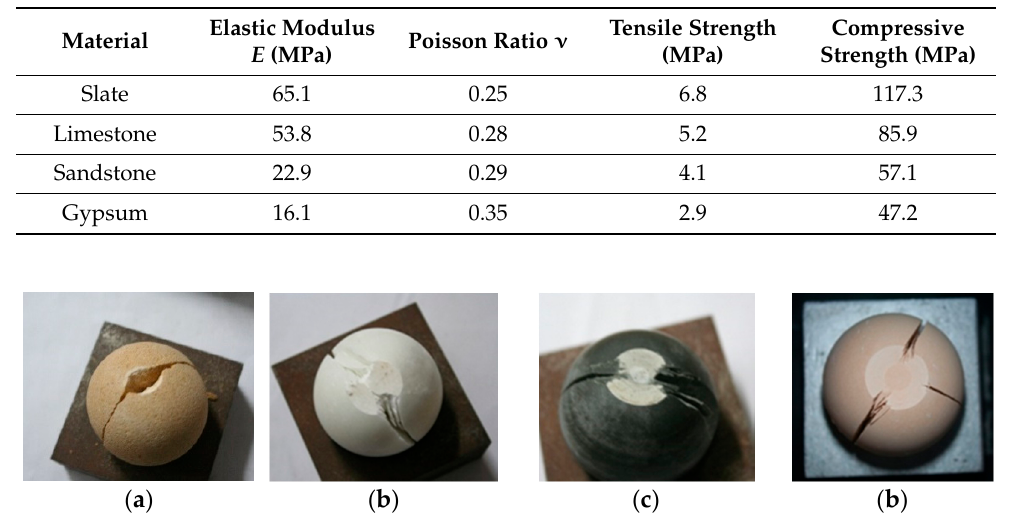
Table 1. Properties of high-strength gypsum and natural materials.